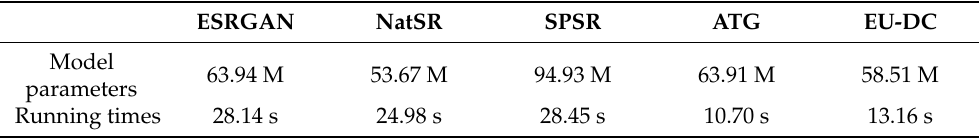
Table 4. A study of the model size and running time. “M” denotes